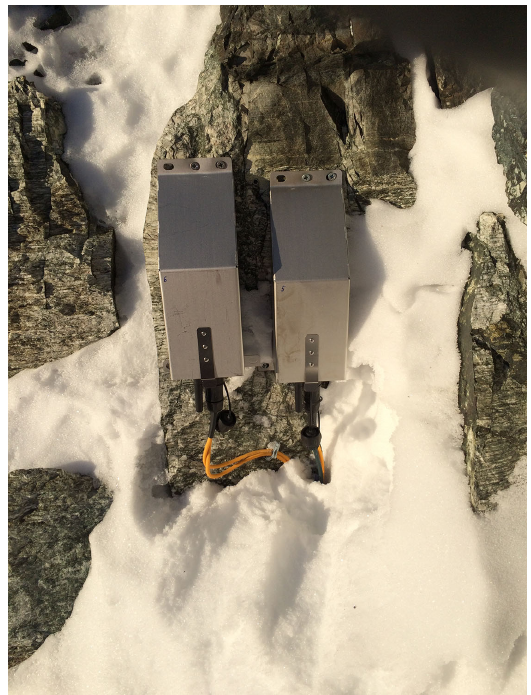
Figure C9. Sensor nodes at position MH05 and MH06 are installed on a small rock wall above a ledge to prevent heavy snow coverage while the sensors themselves are not visible.